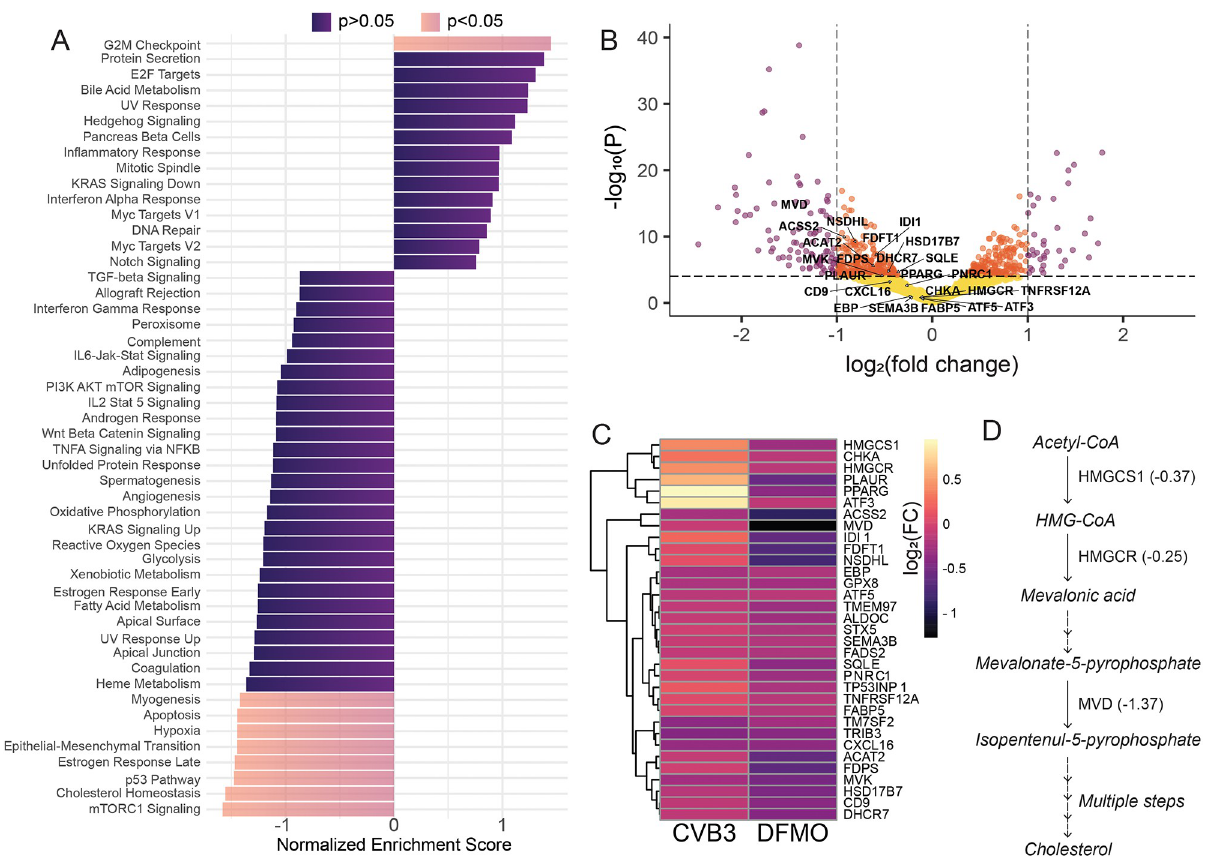
Fig 2. Transcriptomic analysis of DFMO treated cells. Huh7 cells were treated with 1mM DFMO for 96h and subjected to RNA sequencing. Results are based on duplicates. (A) GSEA was conducted on genes differentially expressed by 1mM DFMO treated Huh7 versus untreated Huh7. The top positively and negatively enriched Hallmark pathways were plotted (p.adj < 0.05, purple, p.adj > 0.05, blue). (B) Volcano plot indicating log 2 FoldChange for genes from differential gene expression analysis comparing DFMO treated cells relative to untreated cells. Significant changes in gene expression are plotted in purple for genes: p.adj < 0.05, -1 > log 2 FC > 1, in orange for p.adj < 0.05, -1 < log 2 FC < 1 and in yellow for p.adj > 0.05, -1 < log 2 FC < 1. P-values were adjusted for false discovery rate using Benjamini Hochberg method. (C) Genes from the leading edge of cholesterol homeostasis pathway were subjected to hierarchical clustering for both conditions DFMO treated or CVB3 infected cells relative to untreated cells. Log 2 fold change from target genes are displayed as a heat map. (D) Cholesterol synthesis pathway with the representation of down-regulated genes HMGCS1, HMGCR and MVD. Values indicate fold change in gene